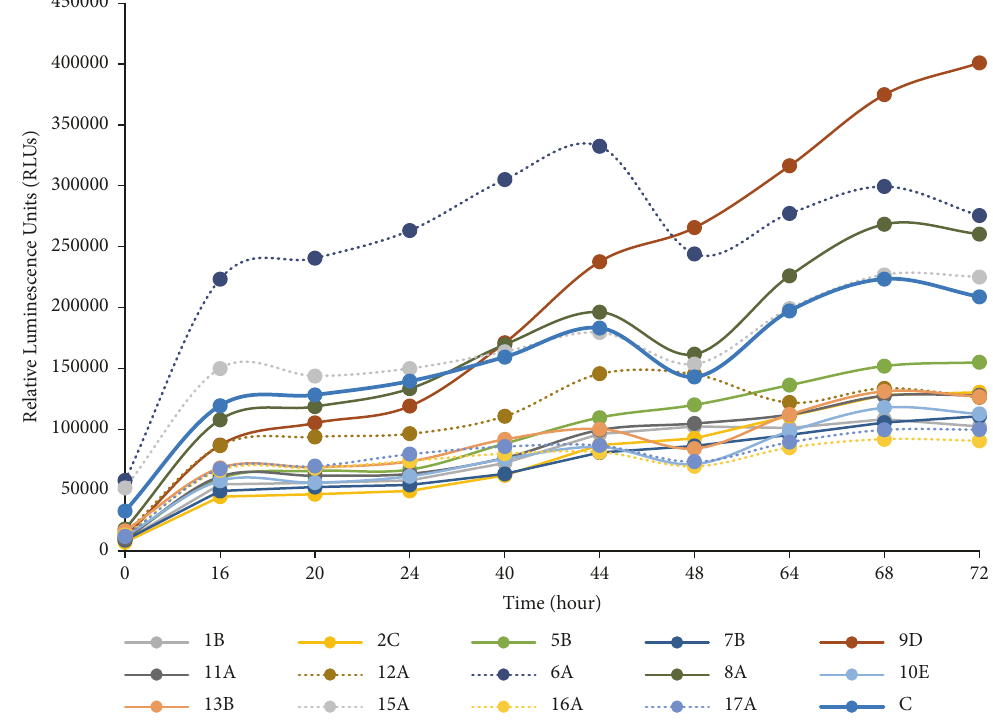
Figure 2: Growth curves of LCLs. Relative luminescence units represent the viability signals of cells at various time points. The filled lines represent the fast-growing LCLs whereas dotted lines represent the slow-growing LCLs. Table 2: Doubling time and growth rate of